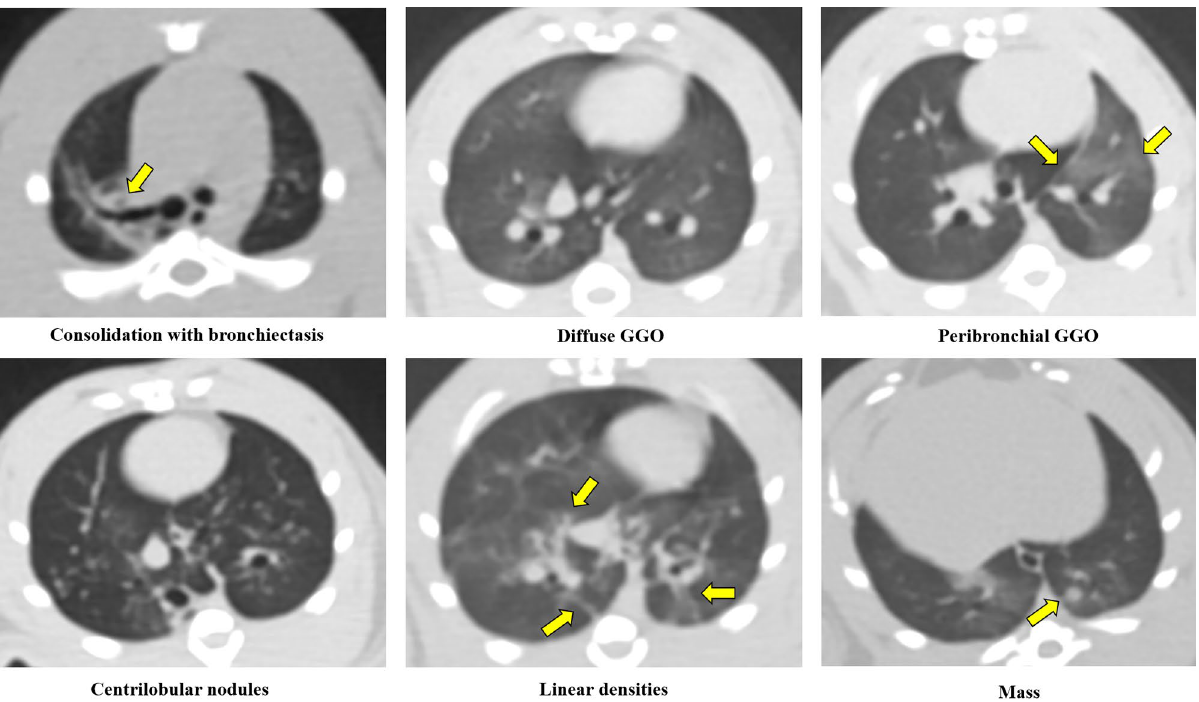
Figure 6. Examples of CT findings. Consolidation, ground-glass opacity (GGO), nodules, masses, centrilobular nodules, bronchiectasis, and linear atelectasis were followed or modified the glossary of radiologic terms suggested by the Fleishner